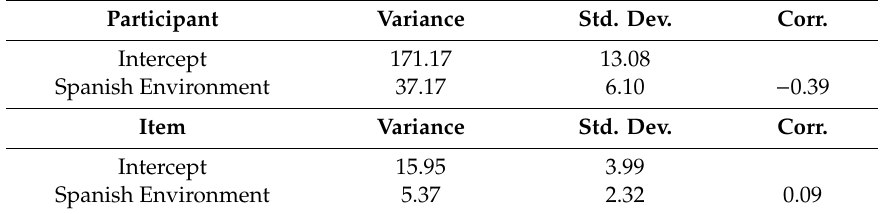
Table A2. Voice Onset Time Model with Proficiency Random E ff ects. Participant Variance